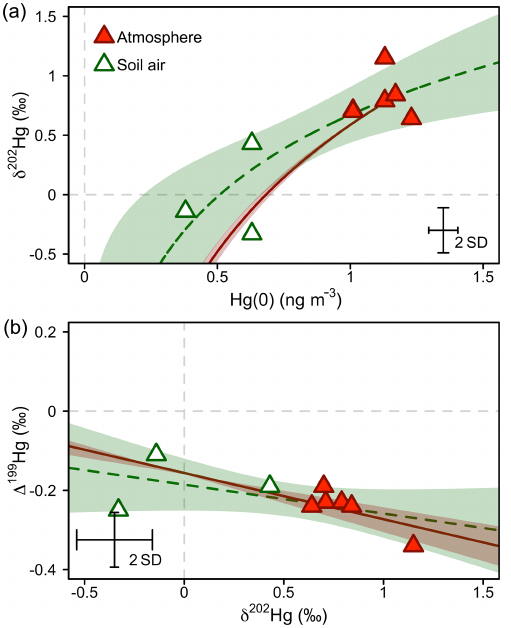
Figure 7. Hg stable isotope systematics of Hg(0) in the atmo- sphere during summer/fall and in soil pore air measured during the same time period. (a) Mass-dependent Hg isotope signature ( δ 202 Hg) against Hg(0) concentration. (b) Mass-independent Hg isotope signature ( (cid:49) 199 Hg) against mass-dependent Hg isotope sig- nature ( δ 202 Hg). The dashed green lines represent the regression of a Rayleigh model (a) and a linear model (b) . The straight red lines represent the trajectories for abiotic dark oxidation of Hg(0) by nat- ural humic acids (HAs) from Zheng et al. (2018). For comparison with observations, the intercept of the linear regressions was ad- justed to fit through the average of atmospheric Hg(0). The shaded areas represent the 95% confidence interval. Error bars represent the analytical precision determined by the 2SD from multiple mea- surements of an in-house